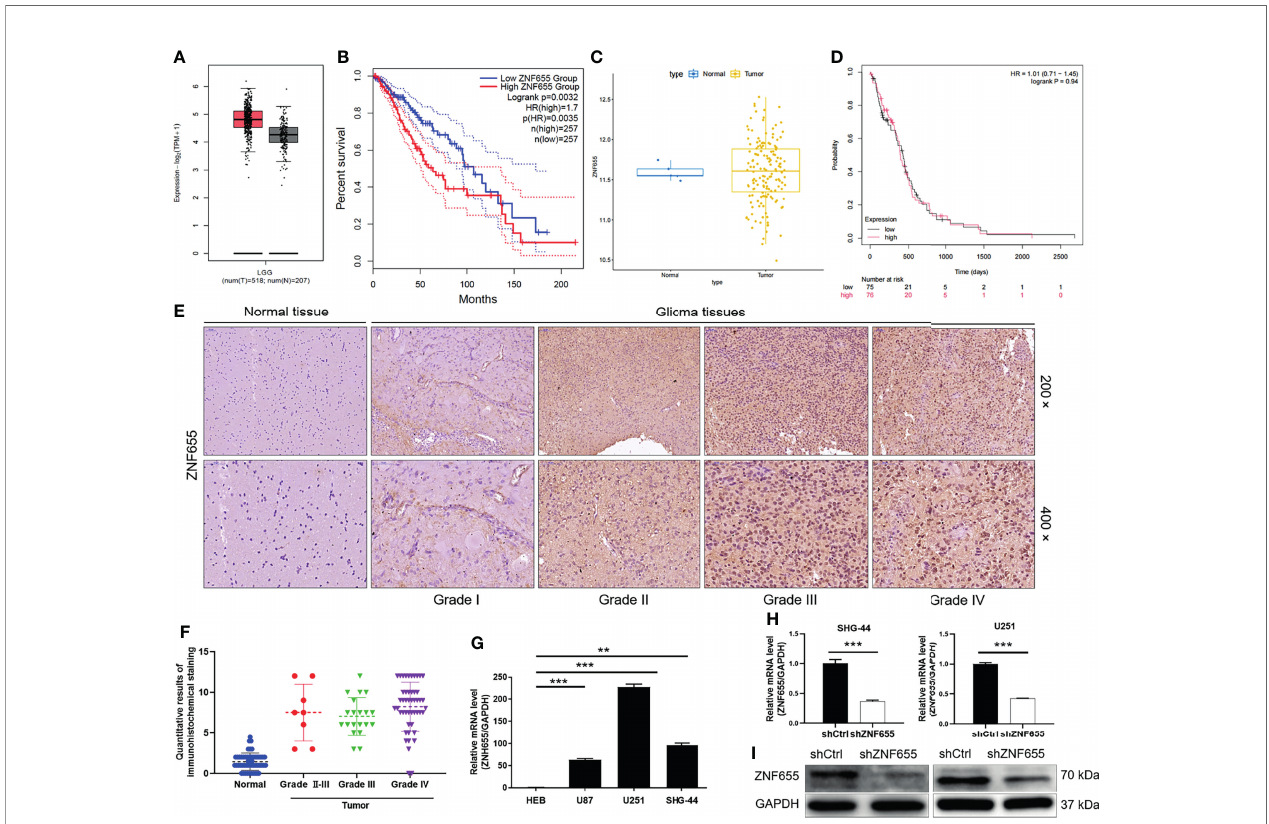
FIGURE 1 | Correlation analysis of the expression level of ZNF655 in glioma and its prognosis. (A) The mRNA level of ZNF655 in human glioma (n = 518) and normal tissue (n = 207) were analyzed from the public available database GEPIA2. (B) The relationship between high or low expression of ZNF655 and prognosis of glioma were analyzed in the GEPIA2 database. (C, D) Based on the TCGA database, the expression level of ZNF655 in glioblastoma and its correlation with survival were analyzed. (E, F) The expression of ZNF655 in glioma tissue (n = 125; low grade, n = 49, high grade, n = 76) and normal tissue (n = 31) were analyzed through IHC staining (×200 magni fi cation and ×400 magni fi cation), and quantitative results of ZNF655 in gliomas were shown. (G) The mRNA expression of ZNF655 was elevated in glioma cell lines (U87, U251, and SHG-44) and human brain normal glial cells HEB. (H, I) The mRNA and protein expression levels of ZNF655 in SHG-44 and U251 cells transfected with shRNA lentivirus were detected. The data were expressed as mean ± SD (n ≥ 3), **p < 0.01, ***p <